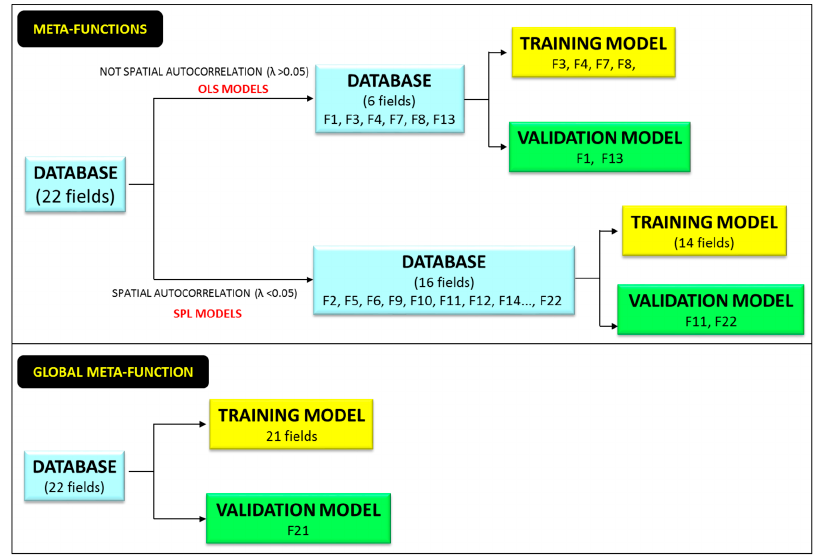
Figure 1. Workflow data integration between database, training and validation models.